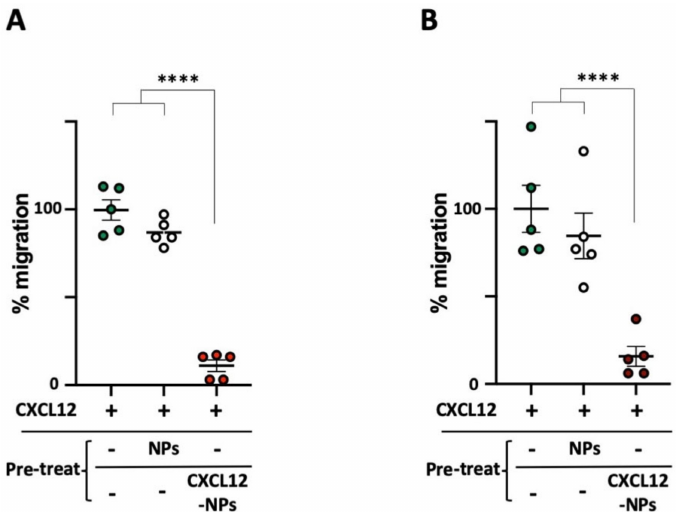
Figure 6. Cell migration towards 10 nM human CXCL12, after the treatment with 32.5 µ g / mL non-functionalized NPs (white dots) and CXCL12-NPs (red dots) in both ( A ) 10% FBS / medium and ( B ) 5% HS / medium. Data are shown in percentage relative to untreated THP-1 cell migration and represent the average of at least five independent experiments +/ − SEM. All the experiments were performed in triplicate. Statistically significant di ff erences were determined by unpaired t test with Welch’s correction **** p <